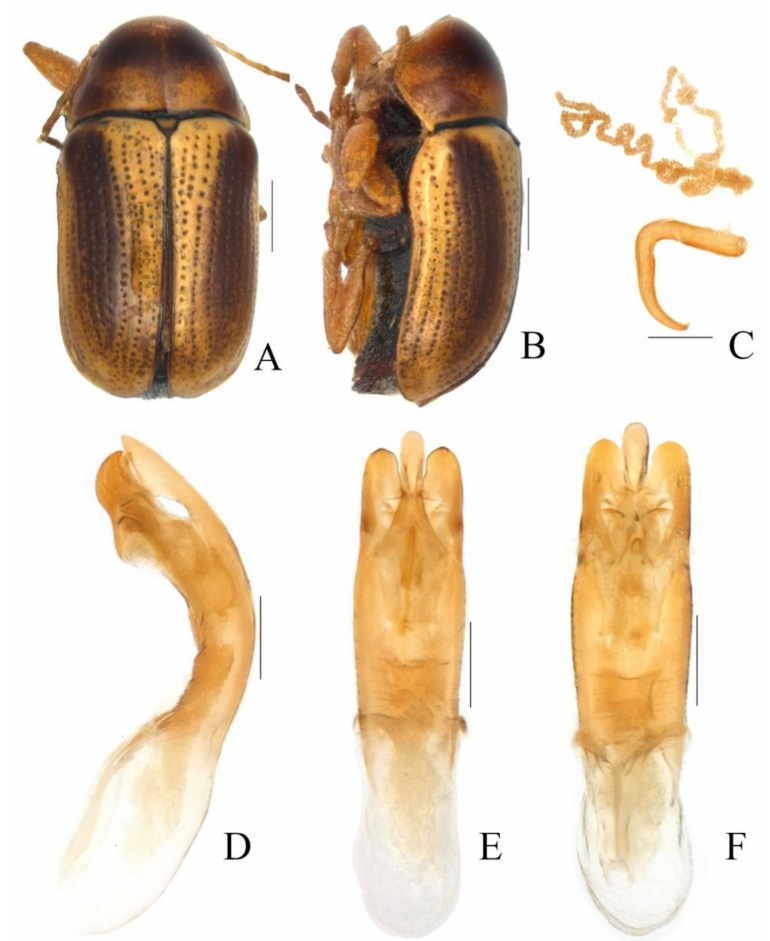
Figure 24. Cryptocephalus ( Burlinius ) nigrofasciatus Jacoby, 1885: ( A ) habitus; ( B ) lateral view of habitus; ( C ) spermatheca; ( D ) lateral view of aedeagus; ( E ) dorsal view of aedeagus; ( F ) ventral view of aedeagus (Scale bars: ( A , B ) = 0.5 mm, ( C – F ) = 0.2 mm) (( A , B , D – F ): male; ( C ): female; both from Hebei).